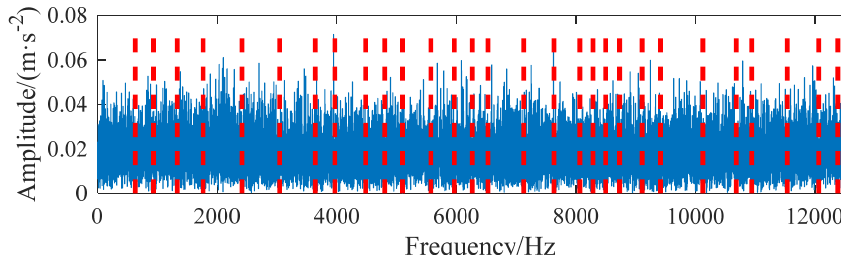
Figure 4. Envelope spectrum of the simulated outer ring fault signal with SNR = − 17 dB.